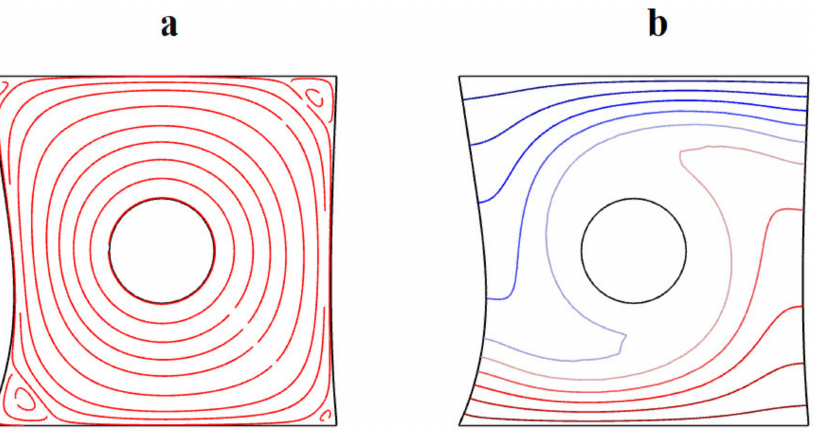
Figure 3. Streamlines ( a ) and Isotherms ( b ) for the validation of the current work results based on the results presented in [36] (page 512; Figure 3).